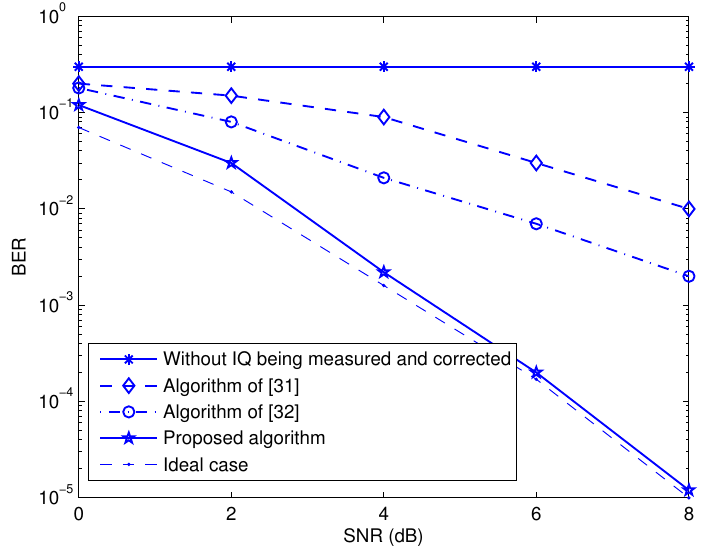
Figure 4. Comparative analysis of the BER performance of several systems.